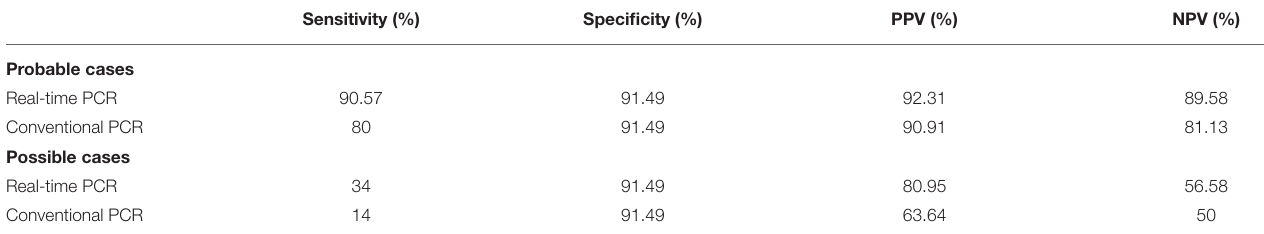
TABLE 2 | Sensitivity, specificity, PPV, and NPV in probable and possible IA